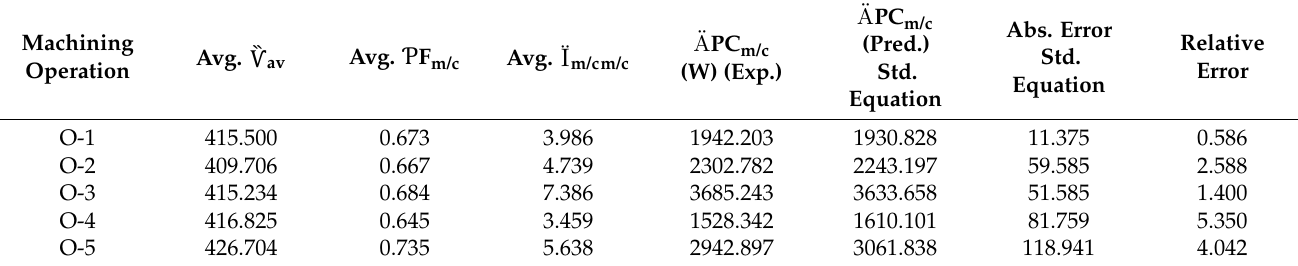
Table 11. Active power determined using standard equation and measured by power analyzer.